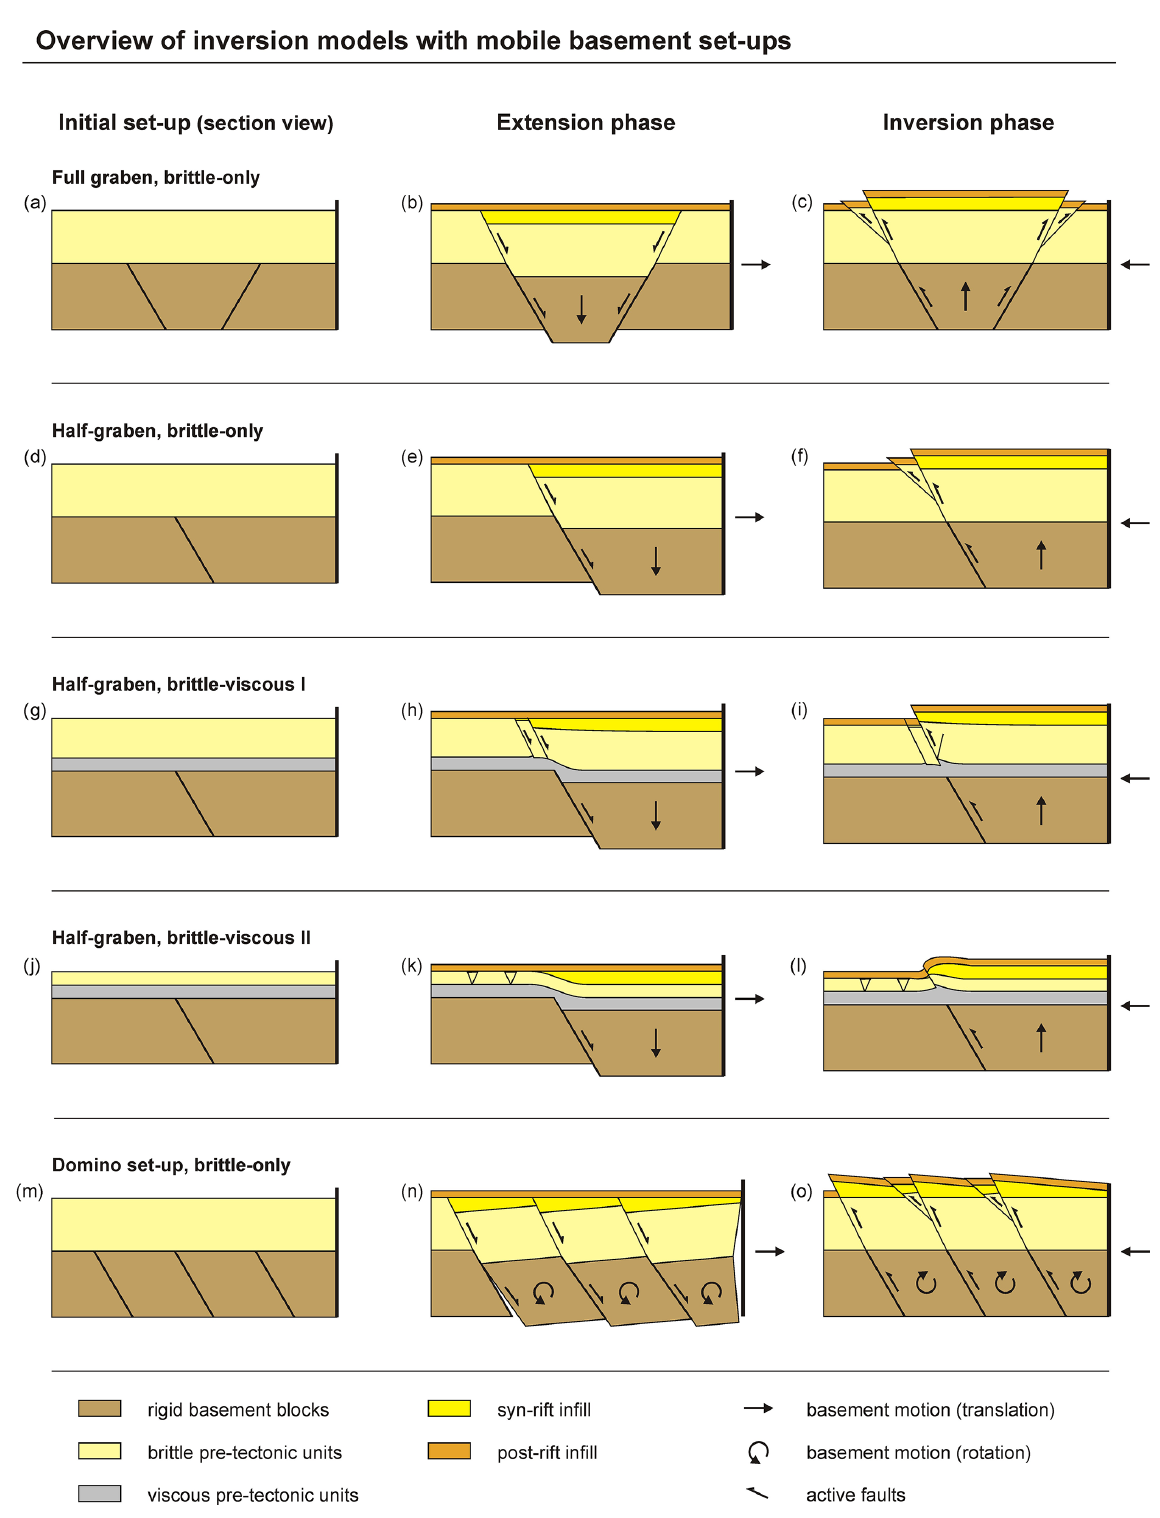
Figure 8. Section-view sketches of idealized results from basin inversion models involving a set-up with mobile basement blocks. (a–c) Full-graben set-up with brittle-only layering. (d–f) Half-graben set-up with brittle-only layering, with very similar inversion structures to those in the full-graben set-up. (g–i) Half-graben set-up I with brittle–viscous layering (high brittle-to-viscous thickness ratio). (j–l) Half- graben set-up II with brittle–viscous layering (low brittle-to-viscous thickness ratio). (m–o) Domino set-up with brittle-only layering. Images inspired by Koopman et al. (1987), Buchanan and McClay (1992), and Burliga et al. (2012b). https://doi.org/10.5194/se-13-1859-2022 Solid Earth, 13, 1859–1905,